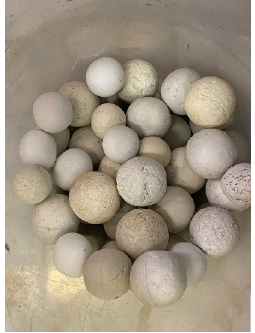
Figure 3. Comminution media.